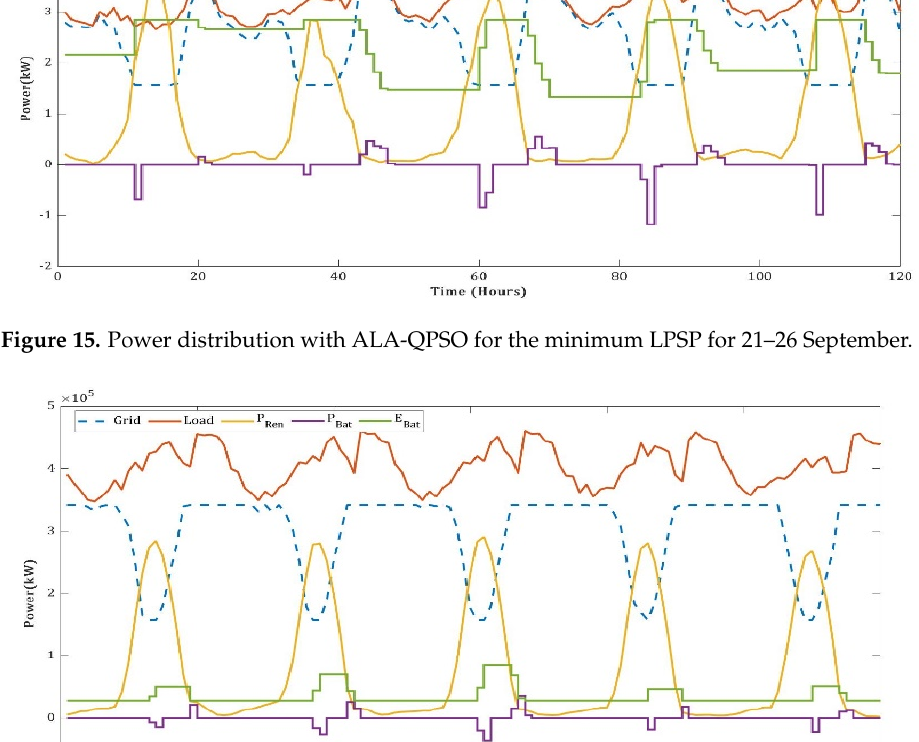
Figure 16. Power distribution with ALA-QPSO for the minimum LPSP for 21–26 December.